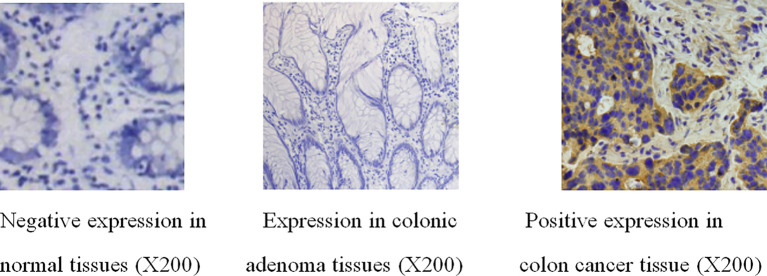
Immunohistochemical results of Wnt7a in normal tissues, colonic adenoma tissues and colonic adenocarcinoma tissues.